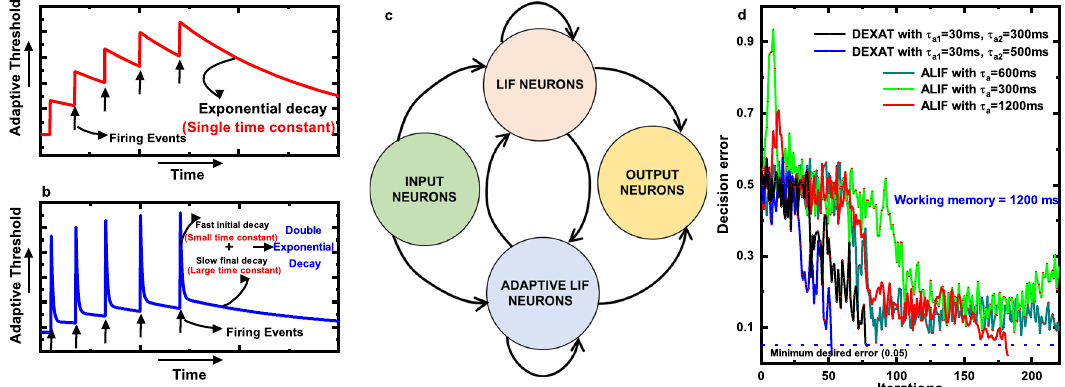
Fig. 1 Qualitative description of neuron models and network architecture for LSNN tasks. a Model in which neuron ’ s threshold decays exponentially with a single time constant and ( b ) Proposed DEXAT model used in this work where threshold decays with two time constants. c LSNN Network used for STORE-RECALL task and ( d ) Learning curves of LSNN with ALIF and DEXAT adaptive neurons on a STORE-RECALL task for a working memory requirement of